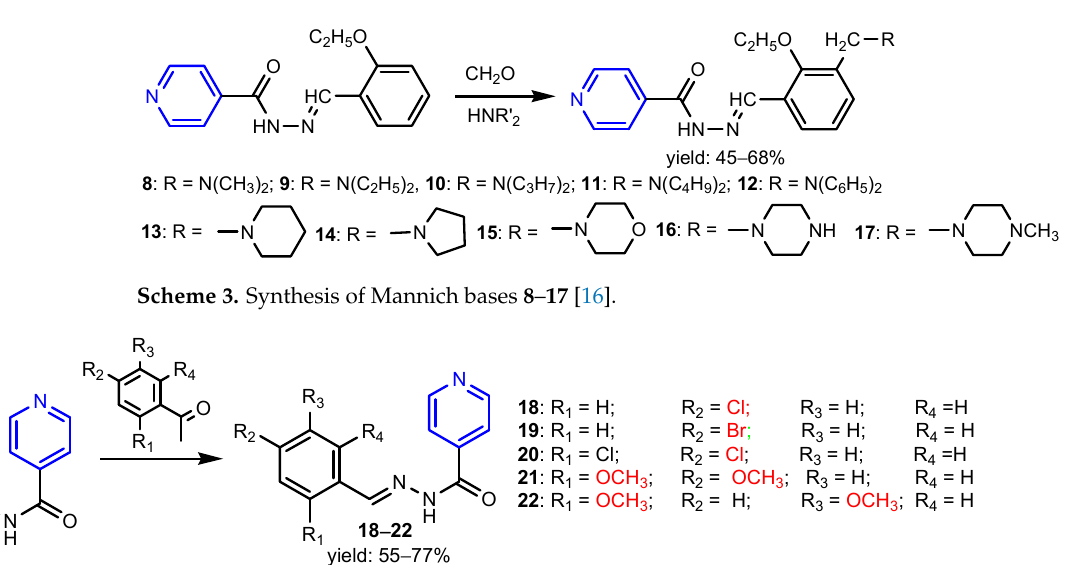
Scheme 2. Synthesis of nicotinic acid benzylidene hydrazide derivatives 4 − 7 [15]. Malhotra et al. [16] synthesized ten substituted Mannich bases 8 − 17 using a classical Mannich reaction starting from 2-ethoxybenzylidene isonicotinohydrazide, formaldehyde and a secondary amine (Scheme 3). The highest antibacterial activity against Gram-positive species B. subtilis , S. aureus and Gram-negative species P. aeruginosa, E. coli were shown by compounds 12 , 15 , 16 , and 17 (MIC = 6.25 − 12.5 µg mL − 1 ) with Amoxicillin as standard. Furthermore, these compounds exhibited a high antifungal activity against C. albicans and C. gabrata species (MIC = 12.5 µg mL − 1 ). Judge et al. [17] synthesized isonicotinic acid-1-(substituted phenyl)-ethylidene hydrazides 18 − 22 by refluxing isonicotinoyl hydrazide with various substituted acetophenones (Scheme 4). Compounds with Br, OCH 3 , and Cl groups were highly active antimicrobial agents, all of them exhibiting activities better than the standard compounds norfloxacin and fluconazole.